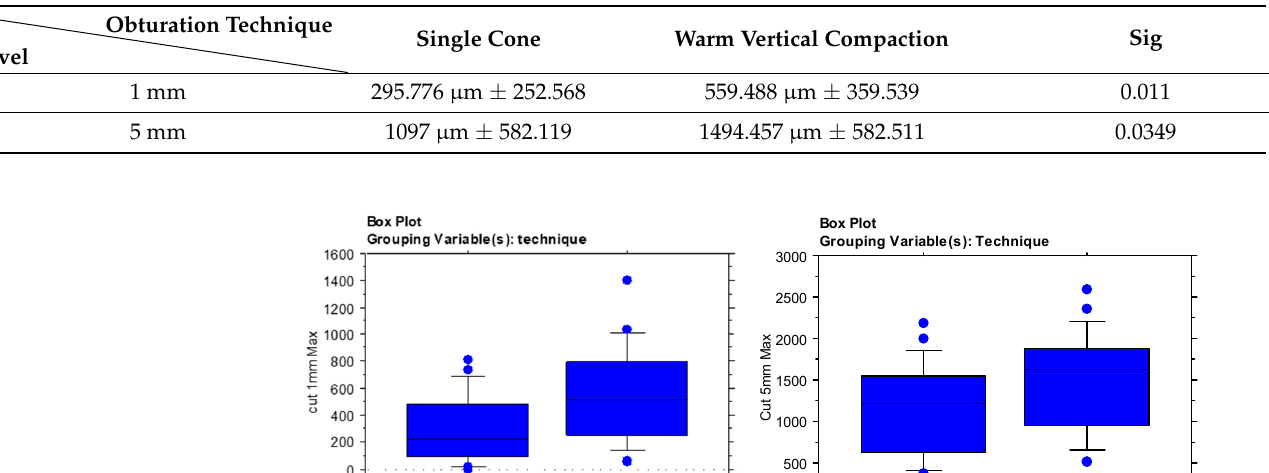
Table 2. Penetration depth ( µ m) according to the obturation techniques at different levels (1 and 5 mm).